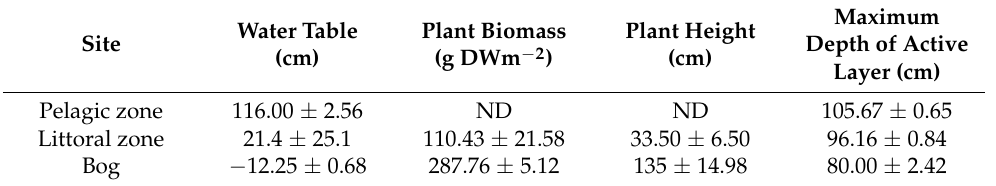
Figure 1. Location of the study area in the Great Hing’an Mountains, Northeast China ( a ). Spatial distribution of the pelagic zone, littoral zone and bog ( b ). Table 1. Biological and environmental parameters of the pelagic zone, littoral zone and